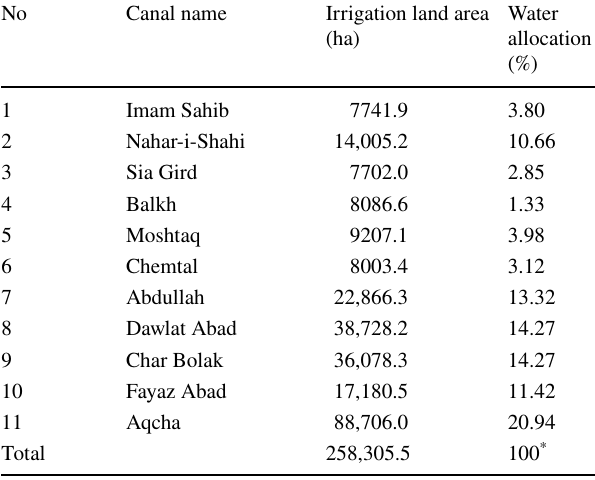
Table 1 Irrigation land area and water rights for the 11